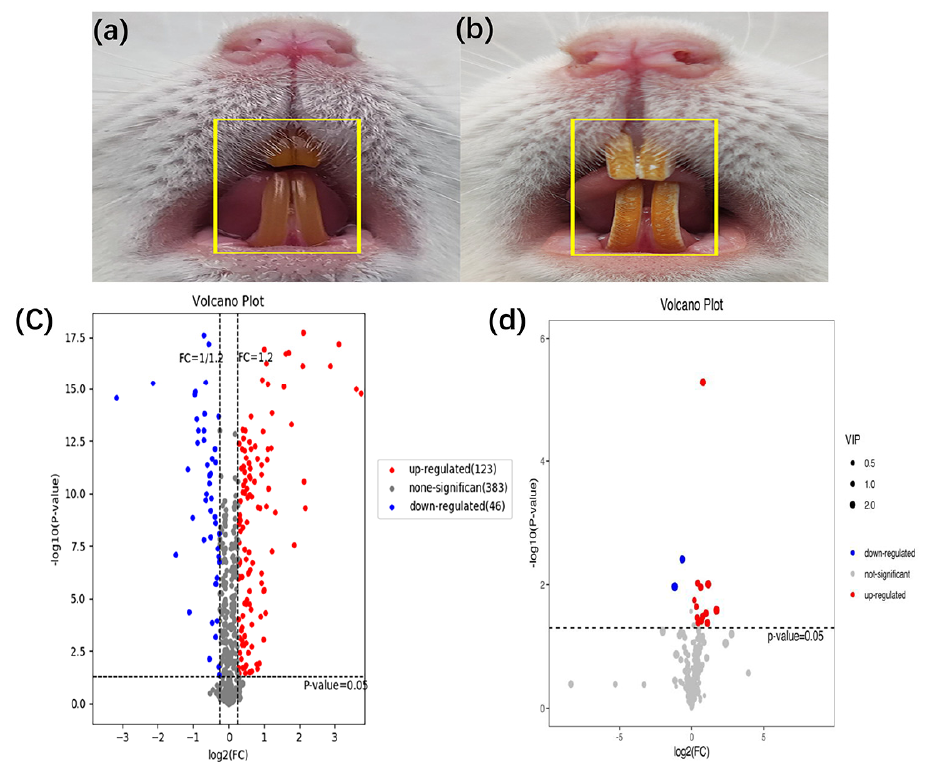
Figure 1. Establishment of animal model for dental fluorosis, ( a ) shows normal dental of mice ( n = 8) and ( b ) shows dental fluorosis of mice ( n = 6). The differentially expressed proteins and metabolites extracted from peripheral blood using the liquid chromatography tandem mass spectrometry and gas chromatography mass spectrometry, the fold change >1.2 or <0.83 and p < 0.05 were considered significant. A total of 169 differentially expressed proteins and 14 differentially expressed metabolites were obtained. The volcano of proteomics ( c ) and metabolomics ( d ) in the dental fluorosis group and control group.